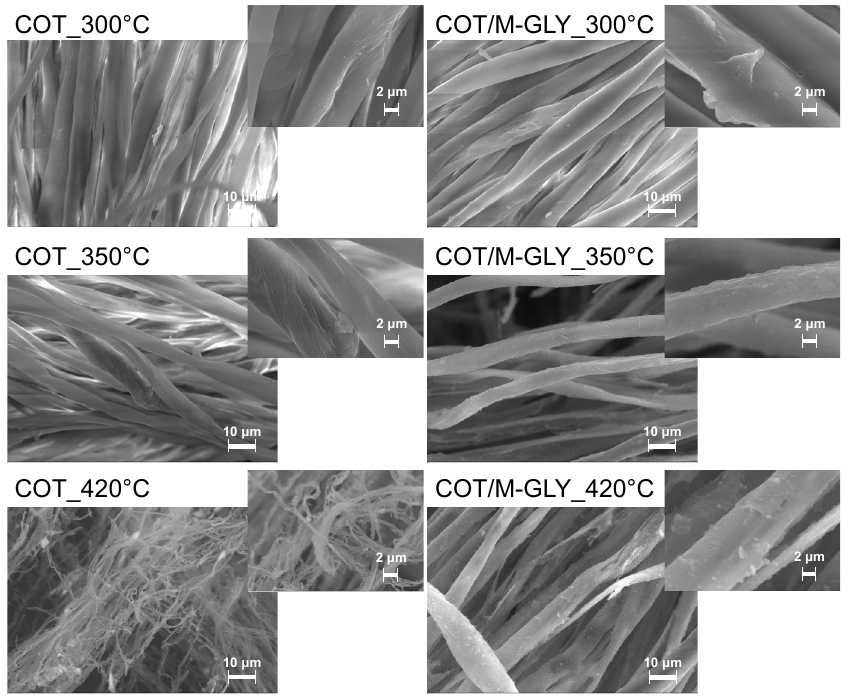
Figure 4. SEM micrographs at 2500× and 10,000× magnifications of COT/M ‐ GLY with 4% M ‐ GLY add ‐ on and untreated cotton (COT) heated in air at 300 °C, 350 °C and 420 °C, respectively.